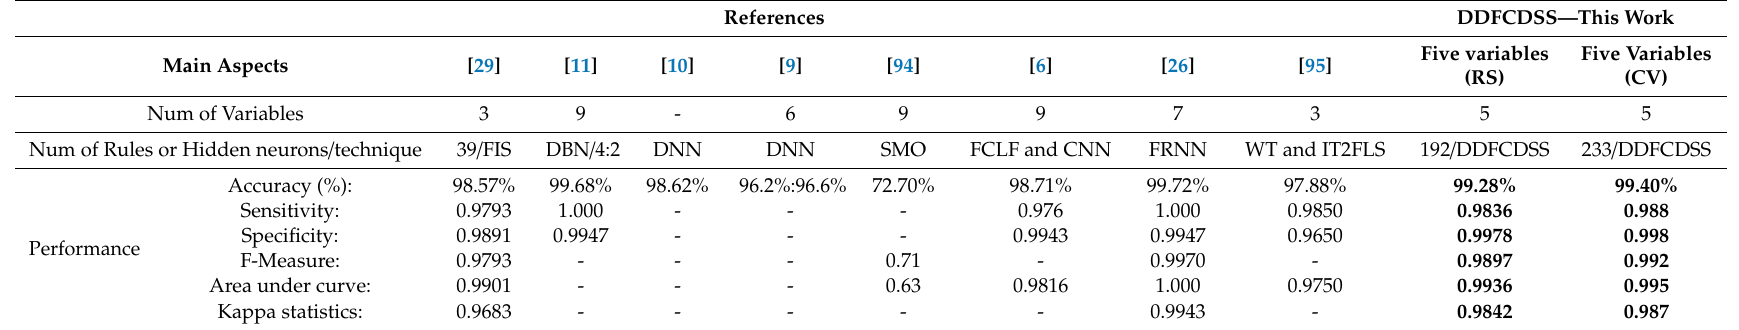
Table 9. Performance metrics obtained with our proposed framework and other classifiers obtained from the literature for WBCD.